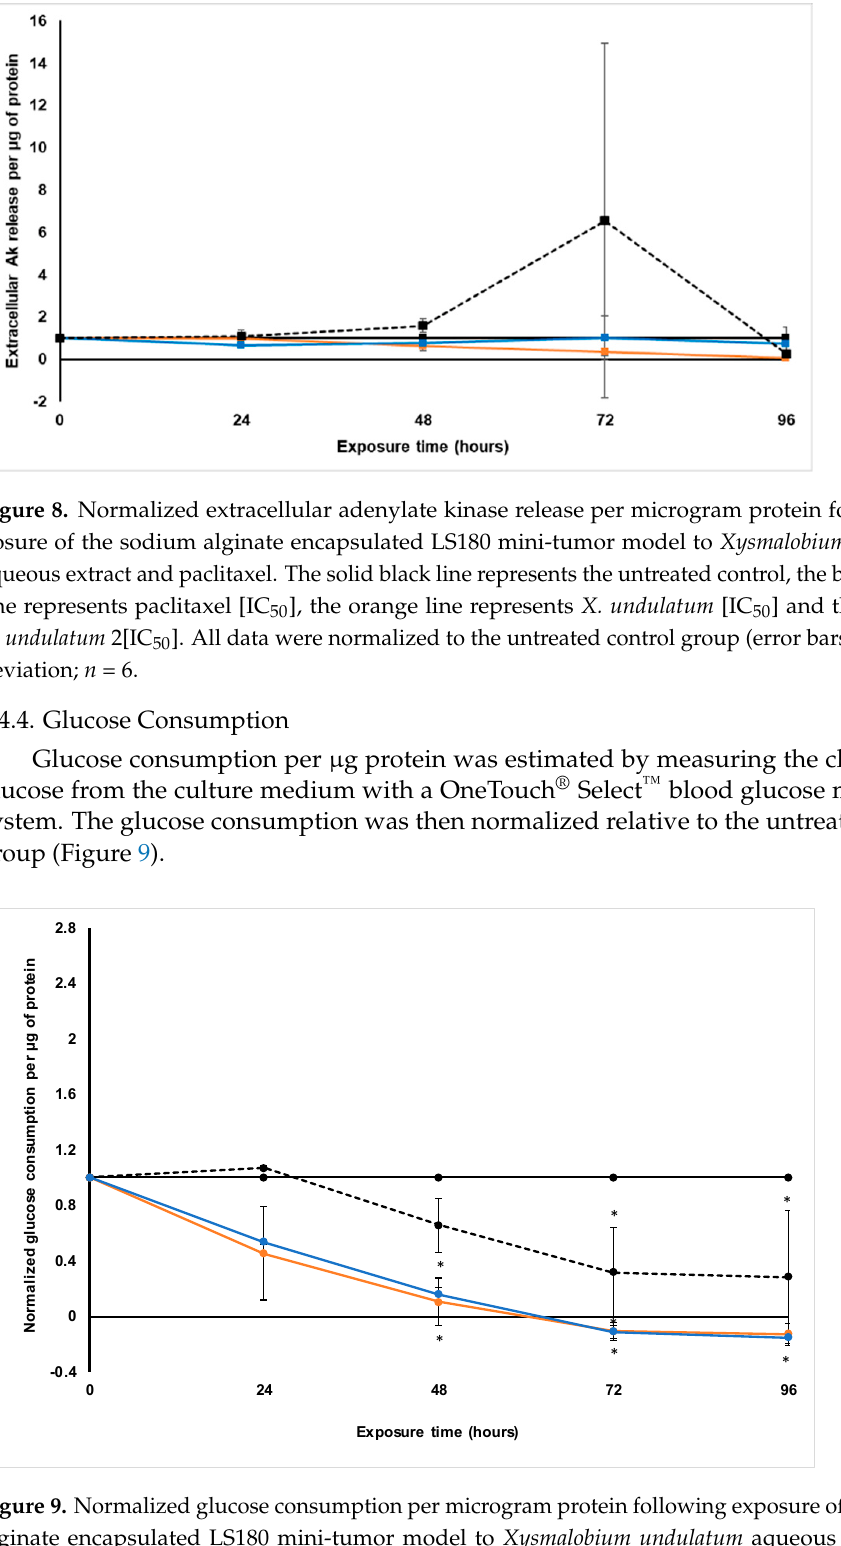
Figure 9. Normalized glucose consumption per microgram protein following exposure of the sodium alginate encapsulated LS180 mini-tumor model to Xysmalobium undulatum aqueous extract and paclitaxel. The solid black line represents the untreated control, the black dashed line represents paclitaxel [IC 50 ], the orange line represents X. undulatum [IC 50 ] and the blue line X. undulatum 2[IC 50 ]. All data were normalized to the untreated control group (error bars = standard deviation; n = 6; * = statistically significant, p < 0.05 (one-way ANOVA followed by the Dunnett post-hoc test). X. undulatum appeared to also increase the glucose content measured in the culture medium slightly, with a glucose content of 7.2 mmol·L − 1 (±0.1) for the X. undulatum [IC 50 ] group and 7.8 mmol·L − 1 (±0.1) for the X. undulatum 2[IC 50 ] group. Glucose consumption decreased steadily following treatment with both concentra- tions of X. undulatum , and this decrease was significant relative to the untreated control from 48 h exposure onwards. The trend was very similar to that of the paclitaxel-treated group [22], although treatment with X. undulatum decreased the glucose consumption faster and much more. When taking into account the decreased soluble protein content and the intracellular ATP content, this decrease in glucose consumption corresponded well with the suggested cell viability and growth reduction due to treatment with X. undulatum. 2.5. Relative Cytochrome P450 Gene Expression The CYP450 superfamily is the largest and most important phase I enzymes, and of these, the CYP3A, CYP2D and CYP2C families are responsible for respectively 50%, 25% and 20% of the biotransformation of all drugs [25]. Since various treatments can influence the expression of these enzymes, which in turn can affect the bioavailability of these treat- ments, it is an important parameter to evaluate when studying new potential treatments. As shown in Smit et al. [22] and Li et al. [26], paclitaxel is known to upregulate the gene expression of CYP3A4 significantly (as much as 16-fold), and CYP2D6 to some extent as well. This, in turn, may lead to metabolic inactivation of the treatment [27]. These effects were found to be dose-dependent.